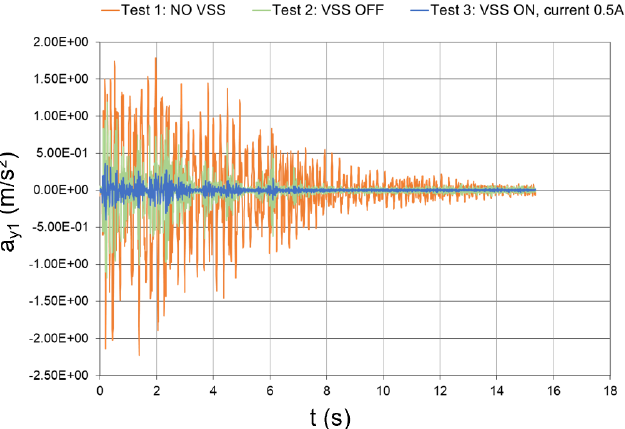
Figure 44. Seismic response, 1st-floor acceleration with respect to the ground (experimental data).